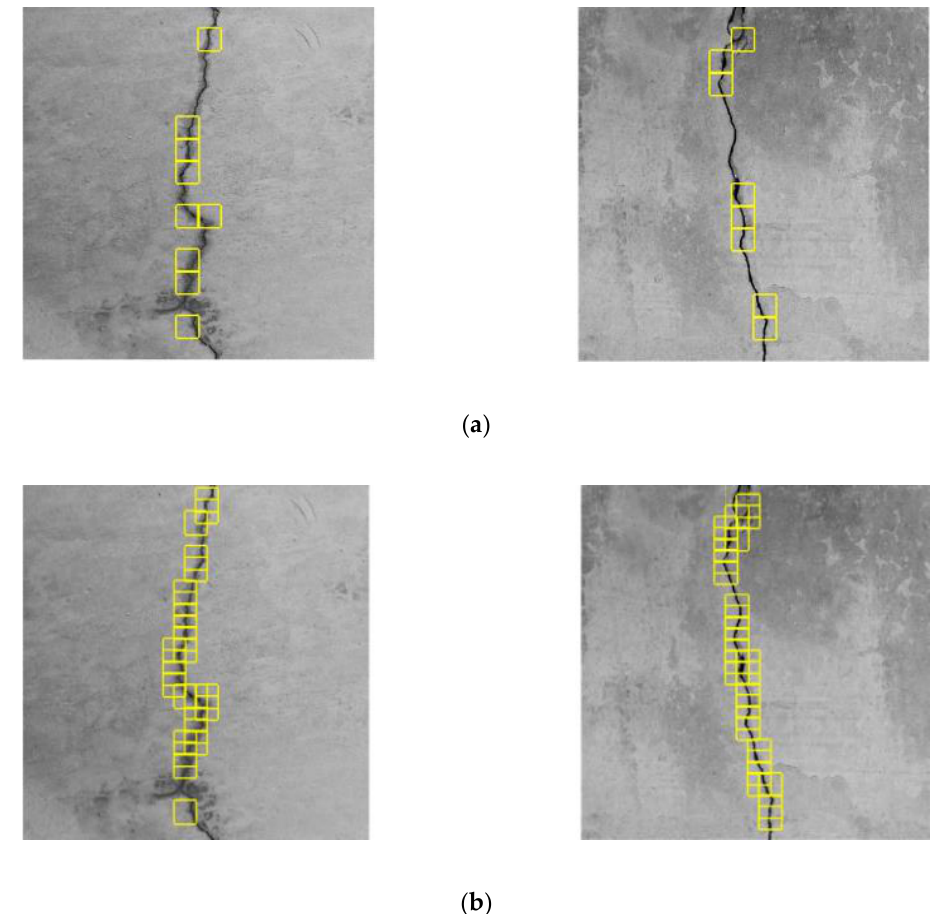
Figure 10. Crack position detection results subject to ( a ) 32 and ( b ) 16 pixels in step size of the sliding